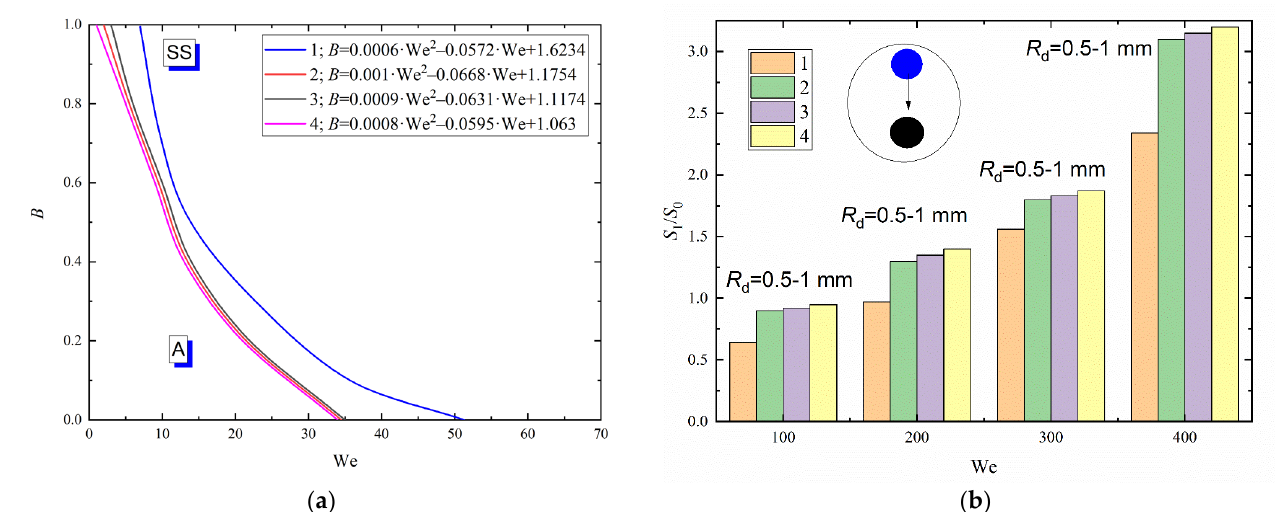
Figure 7. Collision regime maps for liquid droplets interacting with solid particles ( a ) and ratios of free surface areas after ( S 1 ) and before ( S 0 ) the head-on collision with B = 0 ( b ) at varying liquid surface tensions: 1—distilled water; 2—0.5 vol% Tween-20 and 95.5 vol% water; 3—0.5 vol% Tween-80 and 95.5 vol% water; 4—0.5 vol% neonol and 95.5 vol% water.